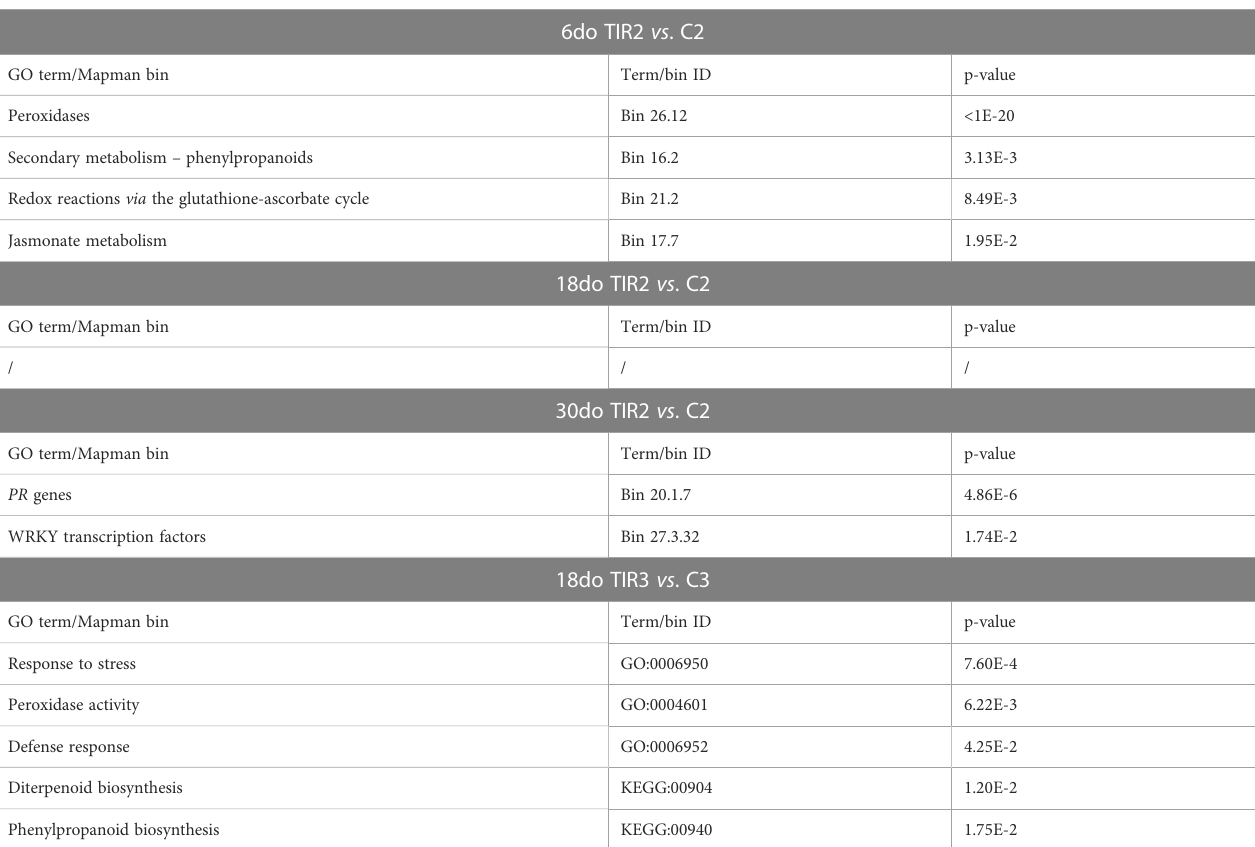
TABLE 2 Diproline-transgenerational induced resistance (diproline-TIR) in rice is associated with transcriptional induction of various defense-related compounds and pathways.